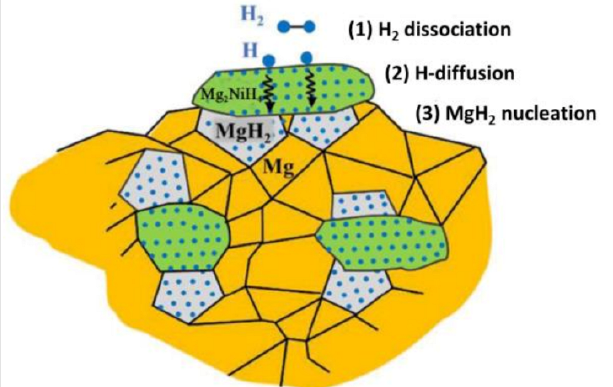
Figure 28. Schematic representation of a Mg–Mg 2 Ni system showing the role of Mg 2 NiH 4 to enhance hydrogen absorption kinetics in Mg. The H 2 molecules, Mg 2 NiH 4 , Mg, and MgH 2 are represented, respectively, by blue, green, orange, and grey colors. Reproduced with permission [37]. Copyright 2019, Royal Society of